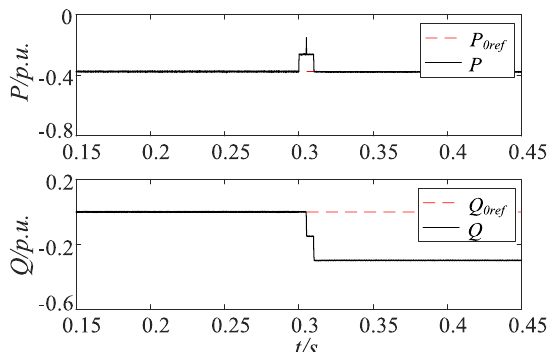
Fig. 16 Positive sequence dq -axis current when the voltage drops under no-load condition